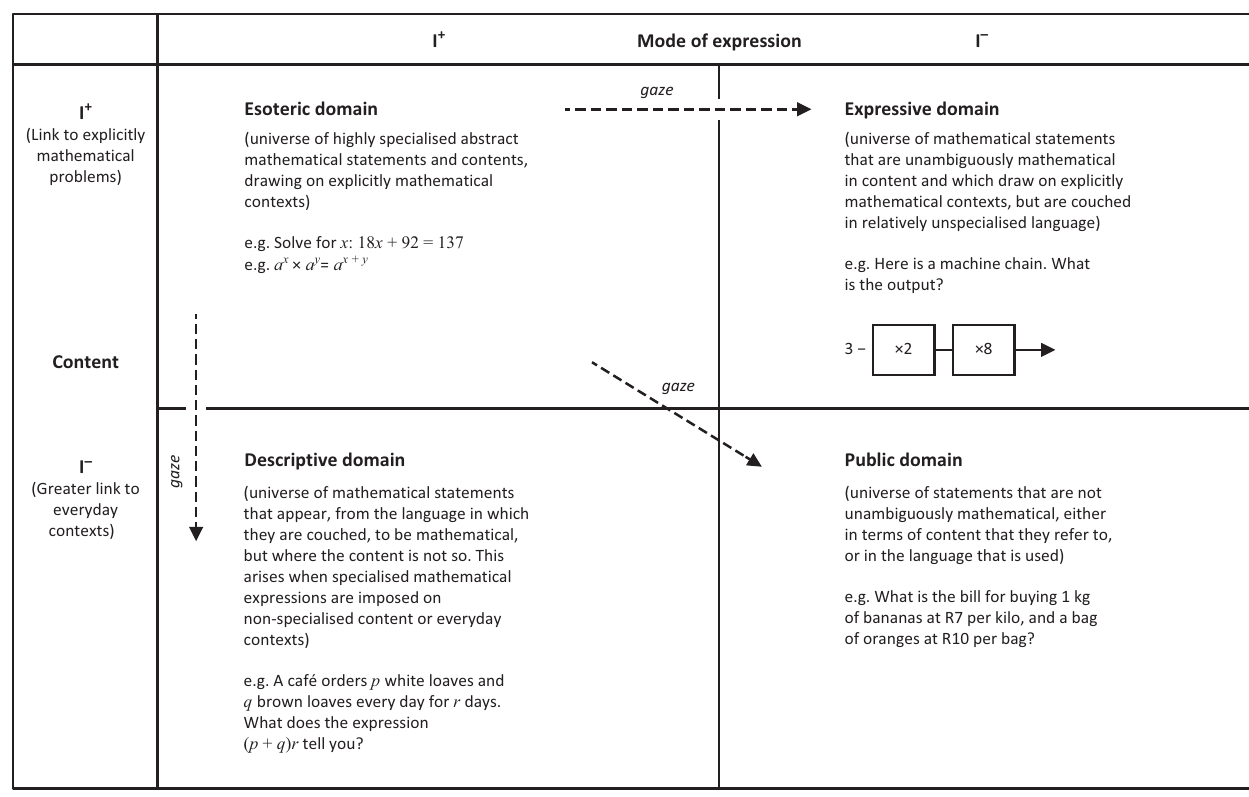
FIGURE 1: Domains of mathematical